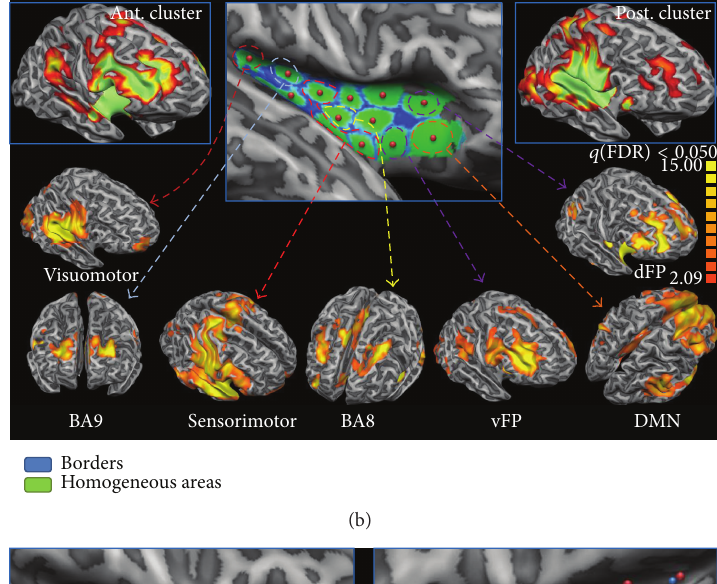
The posterior part of the insula is characterized by smaller clusters and less homogeneity than the anterior part.